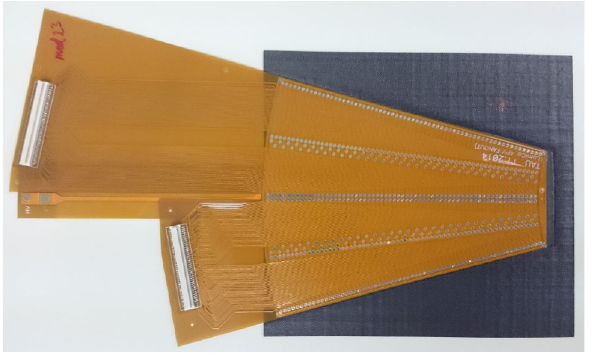
Fig. 4 A thin detector plane. The black part is the carbon fibre support. The silicon sensor is covered by the Kapton fan-out which has two connectors for front-end boards